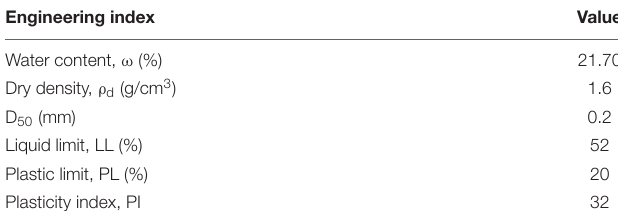
TABLE 1 | Soil index properties of tested samples.